Question: Produce a descriptive caption suitable for publication.
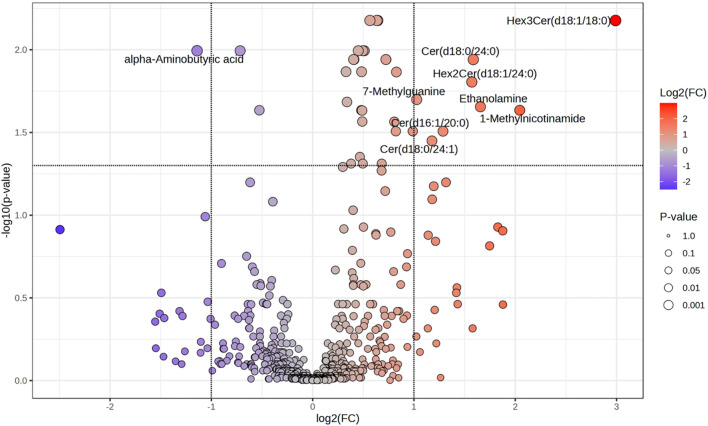
Answer: Volcano map highlighting those metabolites with a Variable Importance in Projection >2. False Discovery Rate < 0.05, and Fold Change threshold >2 of the metabolites analyzed from congenital hypothyroidism patients before and after the treatment onset. Wilcoxon matched pairs signed rank test was performed. Statistical significance [-log 10 or false discovery rate (FDR)-adjusted p-value] on the Y-axis is plotted against the magnitude of change [log 2 Fold Change (FC)] on the X-axis. The FC was calculated as the Pre Tx/Post Tx ratio. Consequently, positive log 2 FC values (right side, red dots) represent metabolites that are significantly elevated Pre Tx and thus decrease following the treatment. Conversely, the negative log 2 FC value (left side, blue dots) represents a metabolite that increases after treatment. Gray dots represent compounds that did not meet both selection criteria.